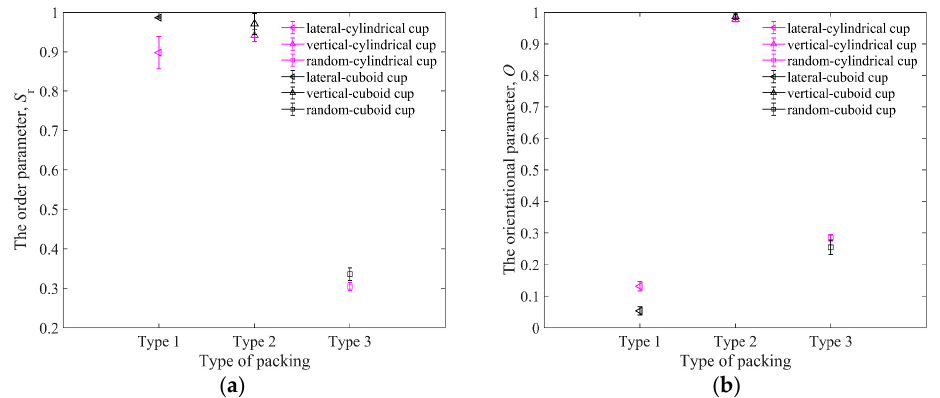
Figure 20. The order parameters and orientational parameters of three packings in cylindrical cup and cuboid cup: ( a ) is the order parameters for three packing types; ( b ) is the orientational parameters for three packing types (type 1—lateral arrangement, type 2—vertical arrangement, and type 3—random arrangement). The length of particles in the cup is L p = 10 mm.